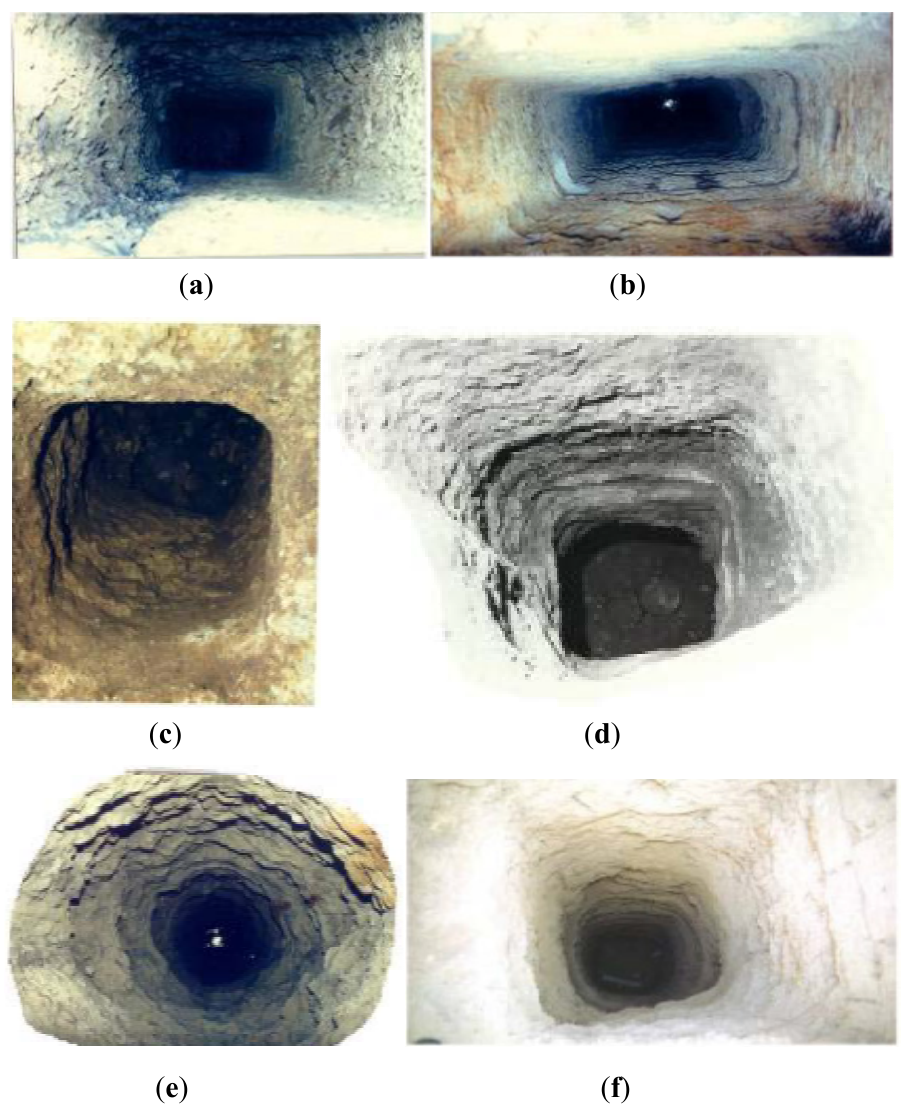
Figure 3. Mouths of vertical shafts catalogued in Palermo: ( a ) squared mouth of the well in via delle Balate ( Albergheria ); ( b ) rectangular mouth of the well in Vicolo Massi dell’Albergheria ; ( c ) squared mouth of the well in via Mongitore ( Albergheria ); ( d ) squared mouth of the well in via Elia ; ( e ) circular mouth of the well in via delle Balate ( Albergheria ); ( f ) squared mouth of the well in the Archbishop’s